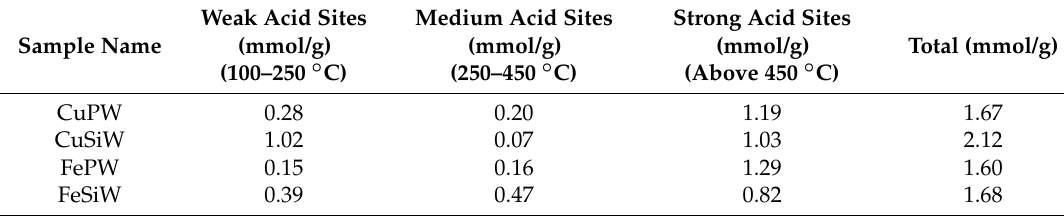
Table 2. Acid sites distribution of the as-synthesized heteropolyacid salt